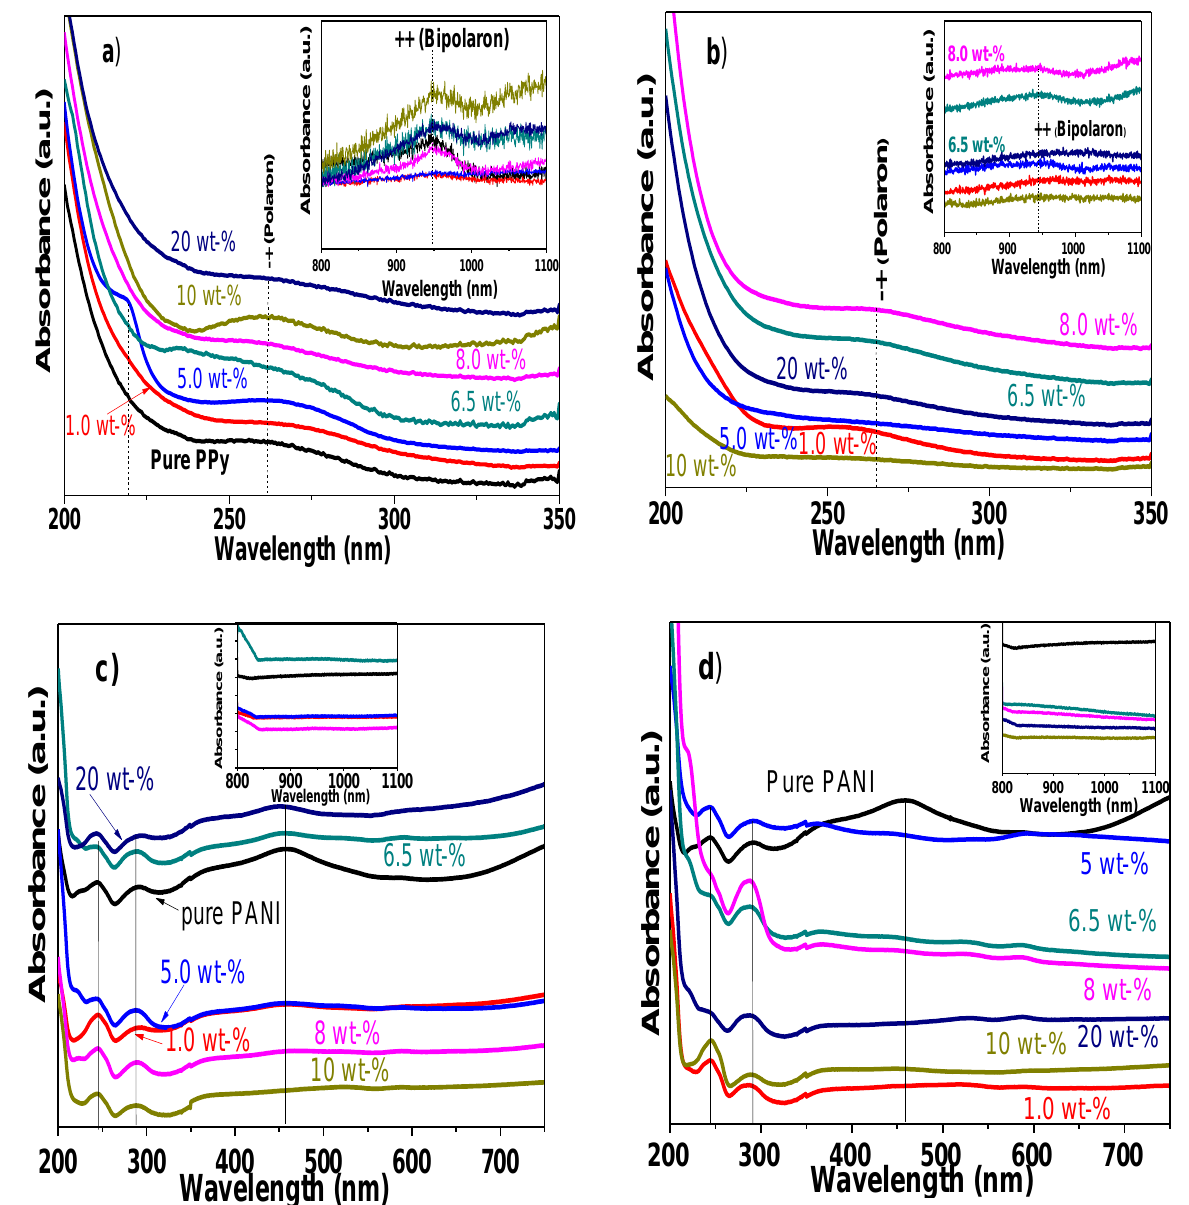
Figure 9. UV-Vis spectra from: ( a ) PPy/synthesized MWCNTs, ( b ) PPy/commercial MWCNTs nanocomposites, ( c ) PANI/synthesized CNTs, and ( d ) PANI /commercial MWCNTs nanocomposites. Pure PPy and PANI films are included as comparison.